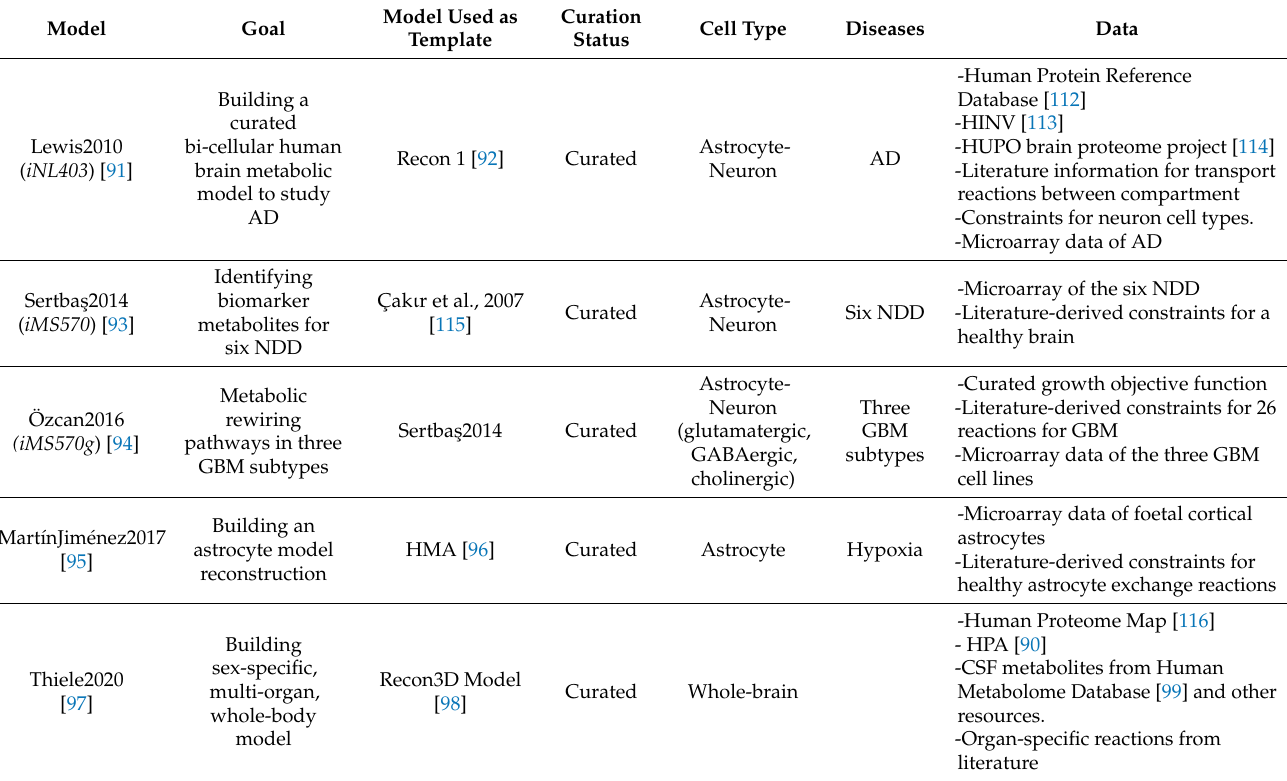
Table 1. Curated, semi-curated and automatically generated human GEMs in the brain and their as- sociated phenotypes. The list of metabolic models in the human brain was classified as curated, semi- curated or AG according to the level of manual curation after model-building. The detailed omic types for the “Data” column and the number of samples are summarised in Supplementary File S1 Table